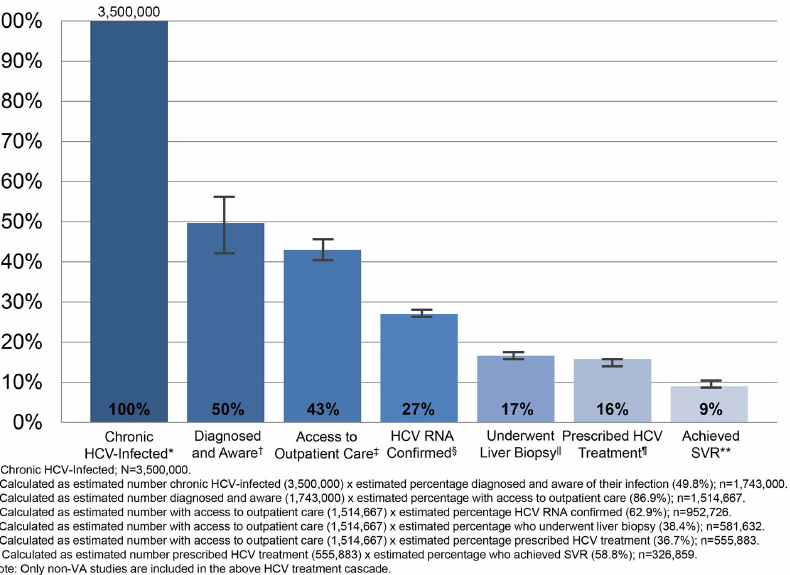
Figure 2. Treatment Cascade for People with Chronic Hepatitis C Virus (HCV) Infection, Prevalence Estimates with 95% Confidence Intervals. * Chronic HCV-Infected; N=3,500,000. { Calculated as estimated number chronic HCV-infected (3,500,000) x estimated percentage diagnosed and aware of their infection (49.8%); n=1,743,000. ` Calculated as estimated number diagnosed and aware (1,743,000) x estimated percentage with access to outpatient care (86.9%); n=1,514,667. 1 Calculated as estimated number with access to outpatient care (1,514,667) x estimated percentage HCV RNA confirmed (62.9%); n=952,726. || Calculated as estimated number with access to outpatient care (1,514,667) x estimated percentage who underwent liver biopsy (38.4%); n=581,632. " Calculated as estimated number with access to outpatient care (1,514,667) x estimated percentage prescribed HCV treatment (36.7%); n=555,883. ** Calculated as estimated number prescribed HCV treatment (555,883) x estimated percentage who achieved SVR (58.8%); n=326,859. Note: Only non-VA studies are included in the above HCV treatment cascade.